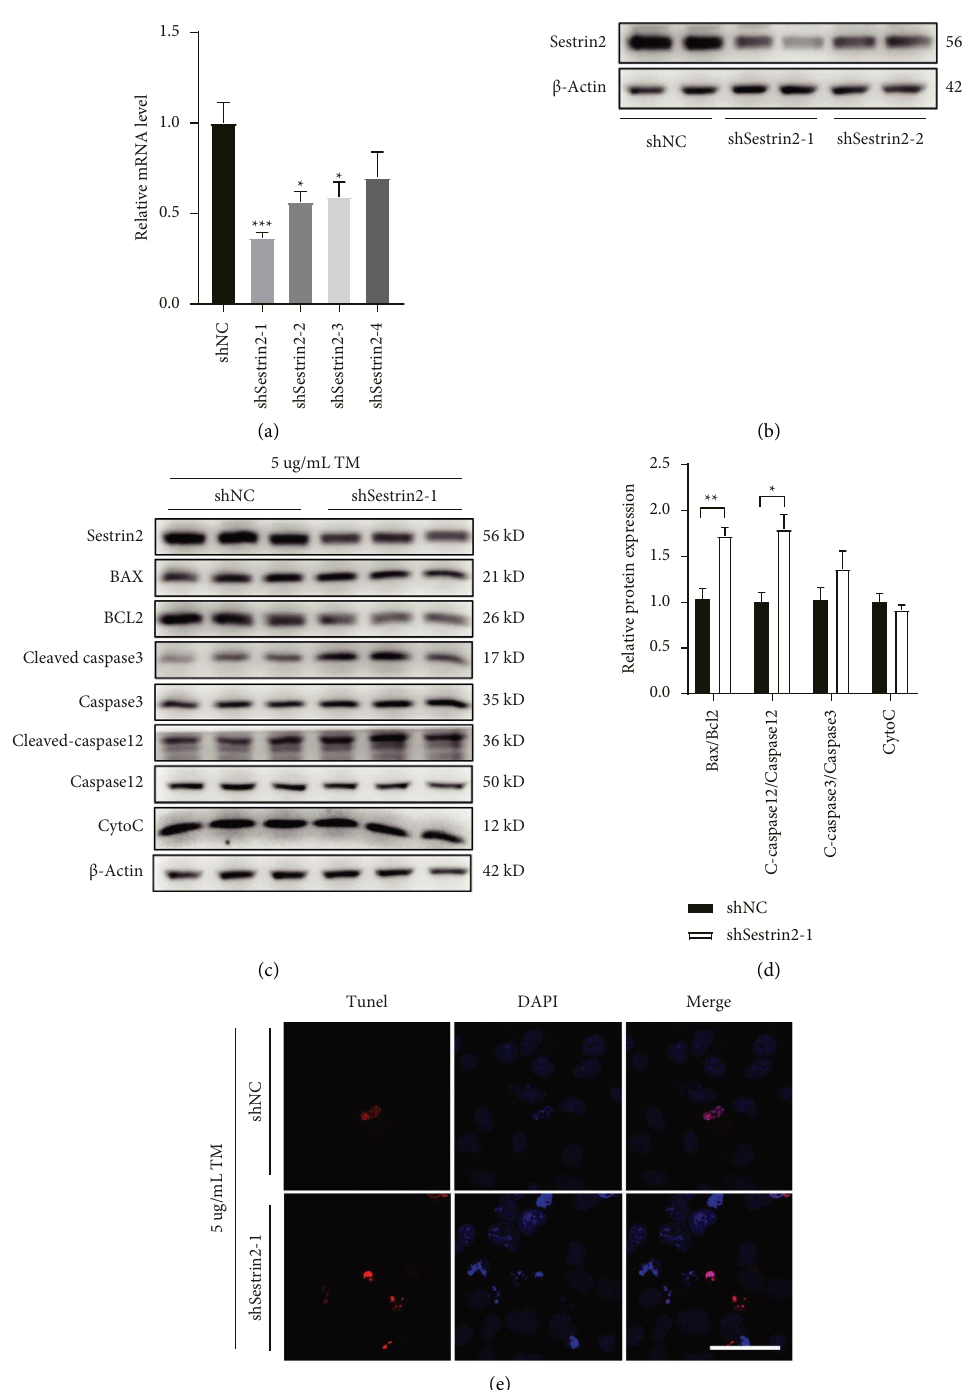
Figure 4: Sestrin2 knockdown promotes TM-induced HepG2 cells apoptosis. (a) shRNA-mediated silencing of Sestrin2 in HepG2 cells was confrmed by qPCR analysis (one-way ANOVA, Dunnett t post hoc test; F (4, 15) � 6.34, P � 0 . 003). (b) Western blot analysis further validating Sestrin2 knockdown in HepG2 cells as determined by protein bands presented at 56kDa. (c) Representative Western blot results of proteins involved with cell apoptosis. (d) Quantitative analysis of proteins involved with cell apoptosis (unpaired two-tailed t -test; for Bax/ Bcl2: t (4) �− 4.61, P � 0 . 010; for C-caspase3/caspase3: t (4) �− 4.15, P � 0 . 014). (e) Representative images of TUNEL positive HepG2 cells in indicated groups. Scale bar, 50 μ m. ∗ P < 0 . 05, ∗∗ P < 0 . 01, ∗∗∗ P < 0 .